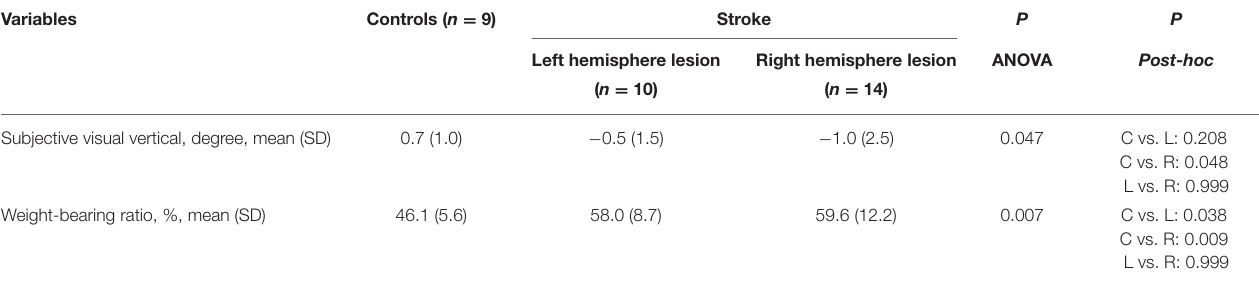
TABLE 3 | Visual verticality and weight-bearing without stimulation in three groups. Variables Controls ( n = 9) Stroke P P Left hemisphere lesion Right hemisphere lesion ANOVA Post-hoc